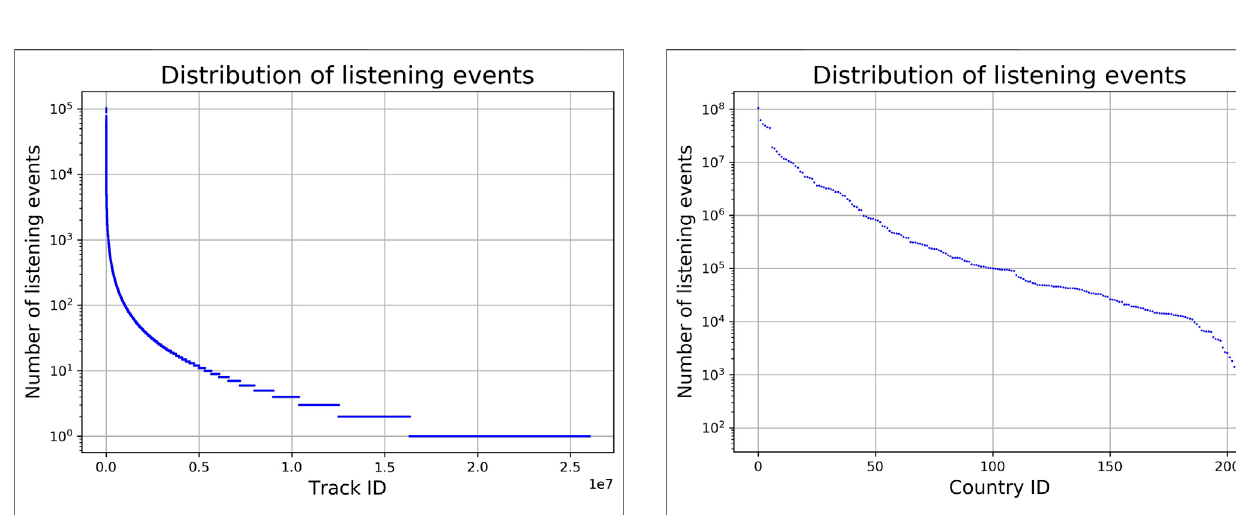
FIGURE 4 | Distribution of number of listening events over all countries (semi-log-scaled). Country identi fi ers are ordered by number of LEs.